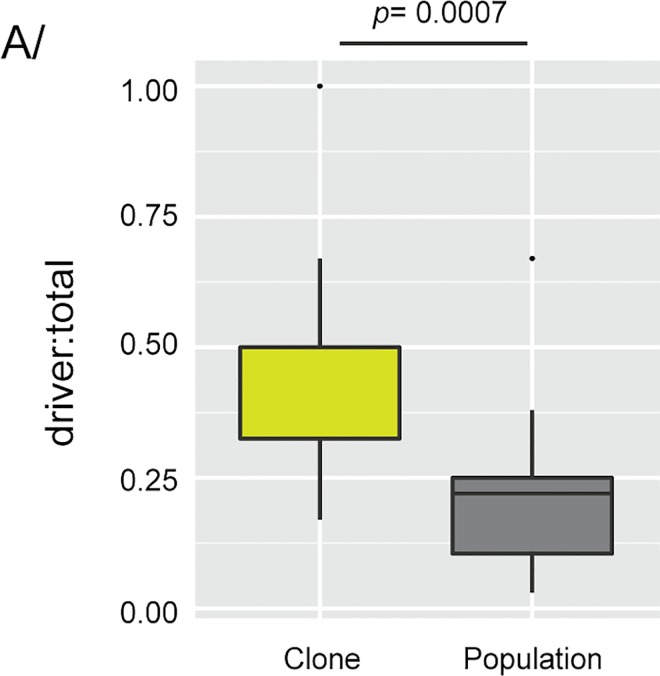
Driver mutations.(A) Boxplot representing the ratio of driver to total mutations detected in evolved clones and populations. The significance of the difference between clones and populations was estimated using a Wilcoxon-ranked test.